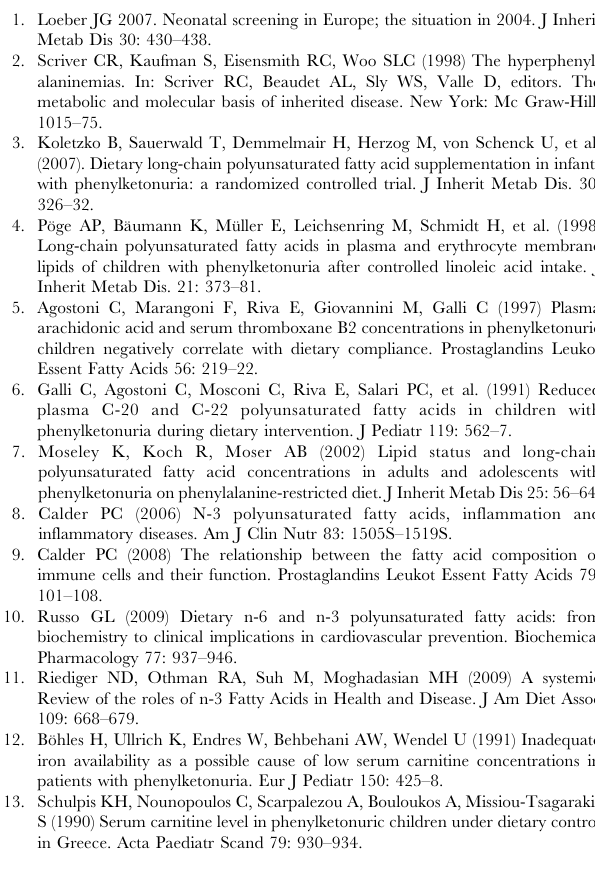
Table S1 Eicosanoids and long chain polyunsaturated fatty acids (LC-PUFA) measured in plasma by liquid chromatography/tandem mass spectrometry (LC-MS/ MS) [ 22 ] . Table S2 Baseline data of patients with phenylketon- uria (PKU) (n= 12) and healthy controls (n= 8). Table S3 Concentrations of activated fatty acids (acyl- carnitines), sterols, and plasma glycerophospholipids composition in patients with phenylketonuria (PKU) and healthy